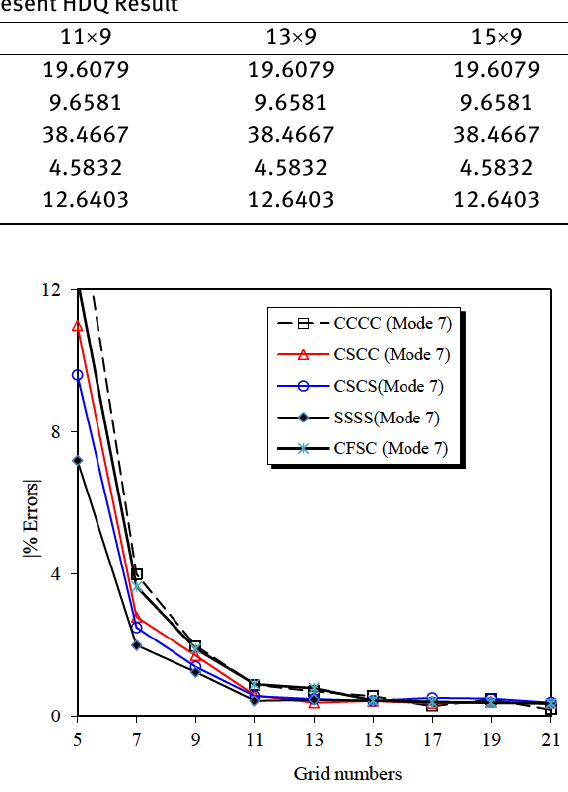
Figure 2: Variation of % errors with grid numbers for different sector angles of CSCS annular sector plate (Mode 5)